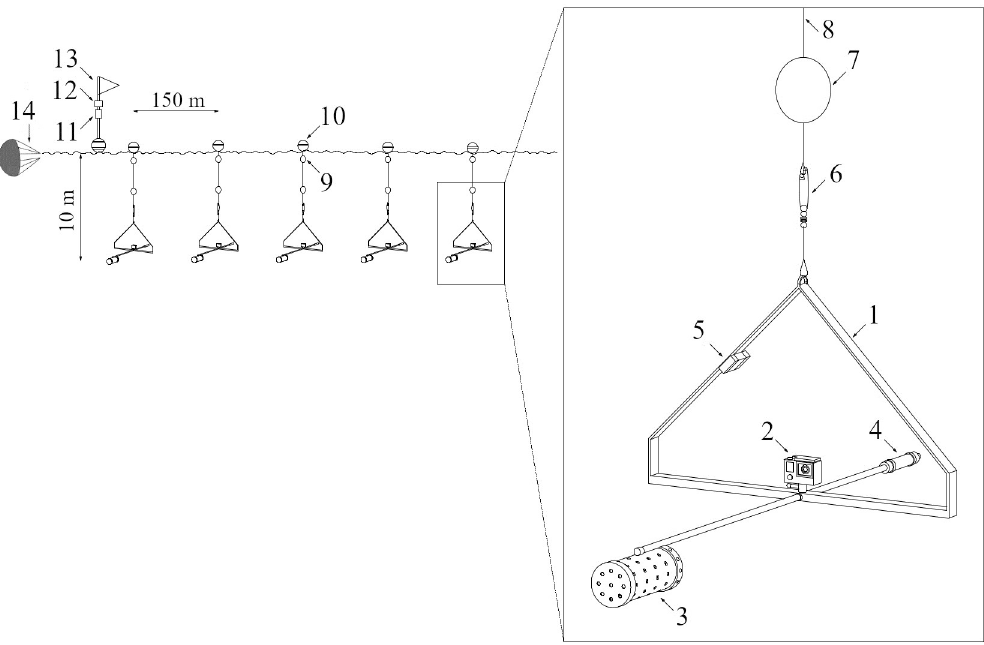
Fig 2. Diagram of a shallow (10 m depth) drifting-pelagic Baited Remote Underwater Video Stations (BRUVS) deployment. Numbers show closer details of a BRUVS unit: (1) Triangle-shaped stainless-steel frame; (2) GoPro camera; (3) Perforated PVC bait container; (4) Counterweight; (5) Temperature sensor; (6) Stainless steel tuna fishing swivel clip; (7) Small intermediate buoy; (8) 10 m or 25 m line; (9) Small surface buoy; (10) Big surface buoy; (11) Global Positioning System device (GPS); (12) Automatic Identification System (AIS) track device; (13) Flag; (14) Sea anchor. The configuration of the deep deployment is the same as the shallow one but BRUVS units are at 25m